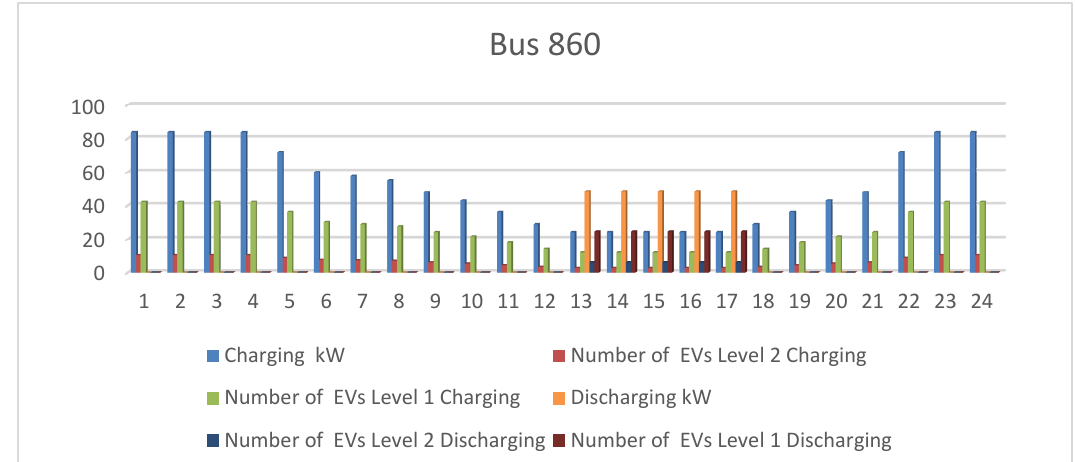
Table 8 . Case 4 Maximum Charging Load kW during Peak Hours. Bus